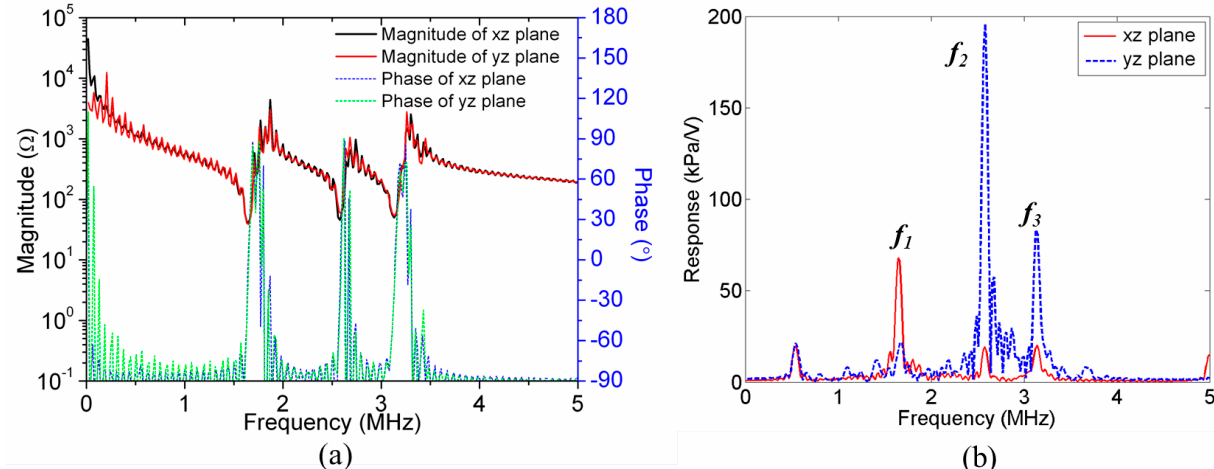
Figure 9. ( a ) Impedance spectra and ( b ) pressure spectra at center point of water layer in xz -plane and yz -plane